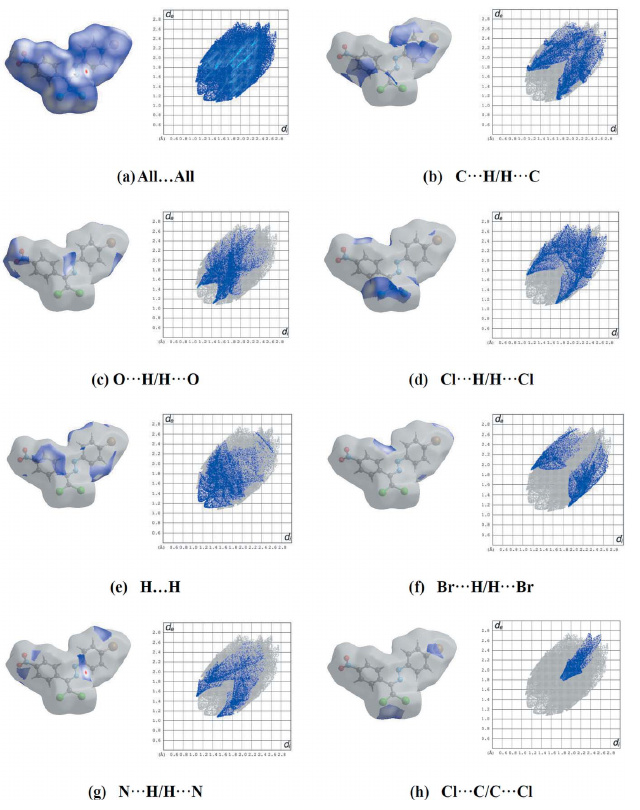
Figure 7 The Hirshfeld surface representations and the full two-dimensional fingerprint plots for (II), showing ( a ) all interactions, and delineated into ( b ) Cl (cid:3)(cid:3)(cid:3) H/H (cid:3)(cid:3)(cid:3) Cl, ( c ) C (cid:3)(cid:3)(cid:3) H/H (cid:3)(cid:3)(cid:3) C, ( d ) O (cid:3)(cid:3)(cid:3) H/H (cid:3)(cid:3)(cid:3) O, ( e ) H (cid:3)(cid:3)(cid:3) H, ( f ) Cl (cid:3)(cid:3)(cid:3) C/C (cid:3)(cid:3)(cid:3) Cl, ( g ) N (cid:3)(cid:3)(cid:3) H/H (cid:3)(cid:3)(cid:3) N and ( h ) Cl (cid:3)(cid:3)(cid:3) Cl interactions. The d i and d e values are the closest internal and external distances (in A˚ ) from a given point on the Hirshfeld